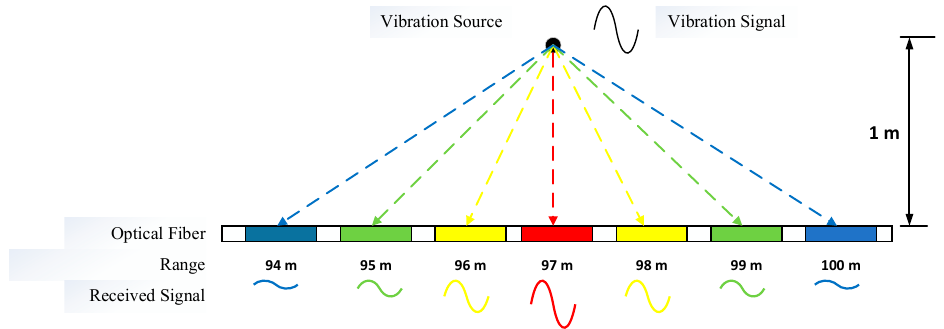
Figure 19. Diagram of optical fiber receiving vibration signal.